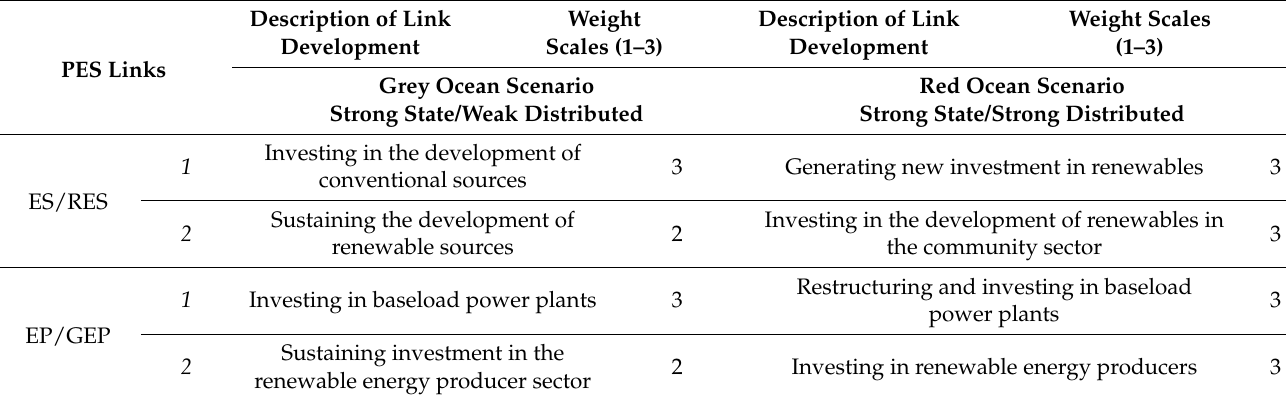
Table 2. Development of PES links in each scenario.